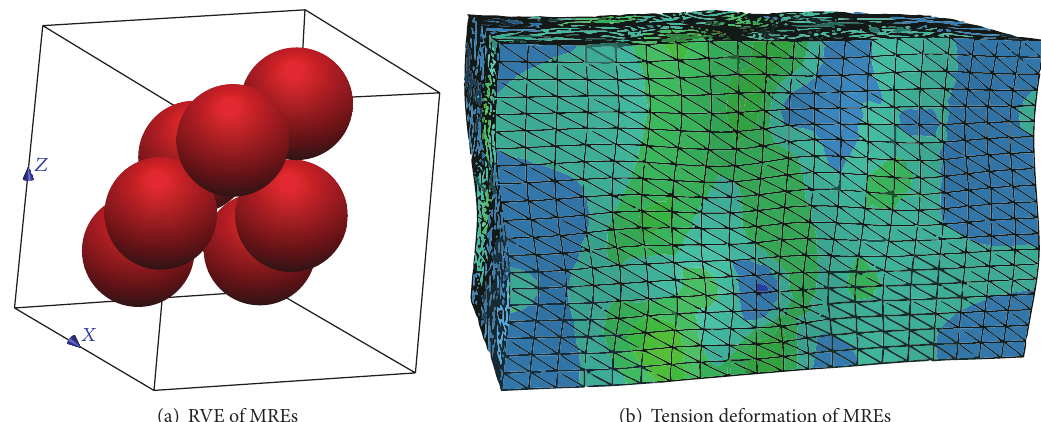
Figure 2: Several particles of orthotropic